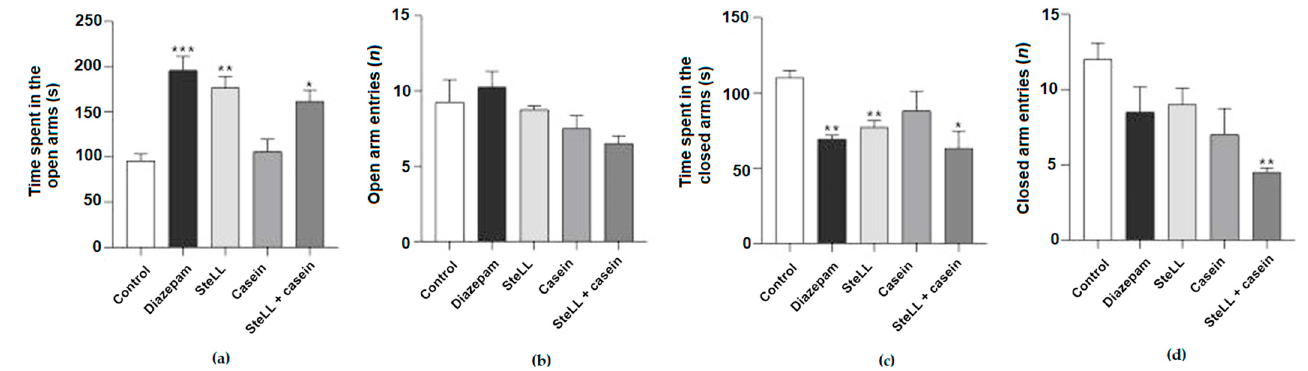
Figure 3. The incubation of the lectin with casein did not revert the anxiolytic effect of SteLL (4 mg/kg) in the elevated plus maze test. ( a ) Total time that mice spent in open arms. ( b ) The number of entries into the open arms. ( c ) Total time spent in closed arms. ( d ) The number of entries into the closed arms. (*) p < 0.05; (**) p < 0.001; (***) p < 0.0001 compared to control.